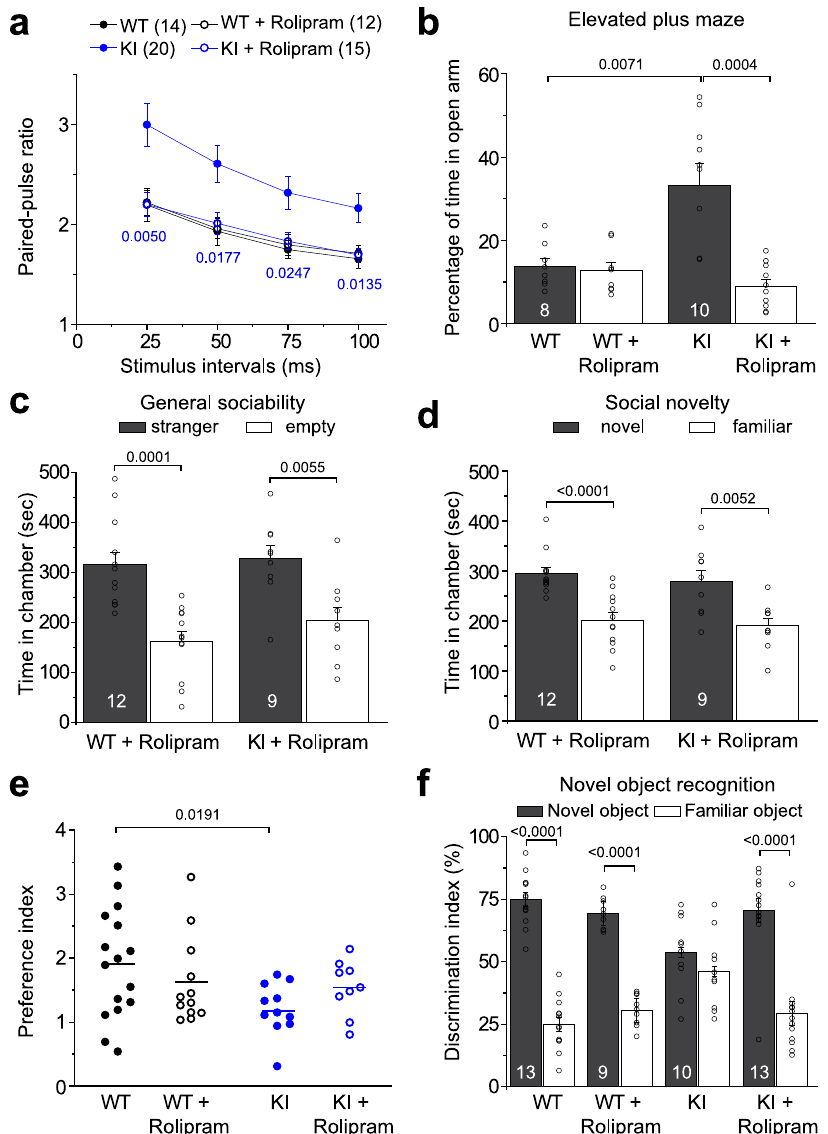
Fig. 4 Synaptic and behavioral impairments in Disc1 KI mice rescued by Rolipram treatment. a Rolipram restored synaptic transmission de fi cits in the hippocampus of Disc1 KI mice. Rolipram (0.1 mg/kg) or vehicle was injected 30 min before sacri fi ce and was present in the bath solution (0.7 μ M) throughout the recording. Values represent mean ± s.e.m.; ( n is indicated in the plot; comparison between KI and KI + Rolipram using One-way ANOVA with p values indicated). The WT and KI without Rolipram treatment from Fig. 3b were replotted here for comparison. b Rolipram normalized the anxiety level of Disc1 KI mice in the elevated plus maze test. Values represent mean ± s.e.m. ( n = 8 for WT and n = 10 for KI, 13-week-old male littermates; One- way ANOVA with p values indicated). c – e Rolipram rescued the social behavioral de fi cits of Disc1 KI mice in the 3 chambers social interaction test. There was no effect of Rolipram on general sociability ( c ), but Rolipram treatment restored the social novelty recognition of KI mice ( d ). Shown in e is a summary of the calculated preference index for novel and familiar mice with or without Rolipram treatment. Values represent mean ± s.e.m. ( n = 16 for WT, n = 13 for WT + Rolipram, = 11 for KI, and n = 10 for KI + Rolipram; 16-week-old male littermates; One-way ANOVA with p values indicated). f Rolipram rescued the cognitive-behavioral de fi cits of Disc1 KI mice in the novel object recognition test. Values represent mean ± s.e.m. ( n is indicated in the plot, 15-week-old male littermates; One-way ANOVA with p values indicated). Source data are provided as a Source Data fi